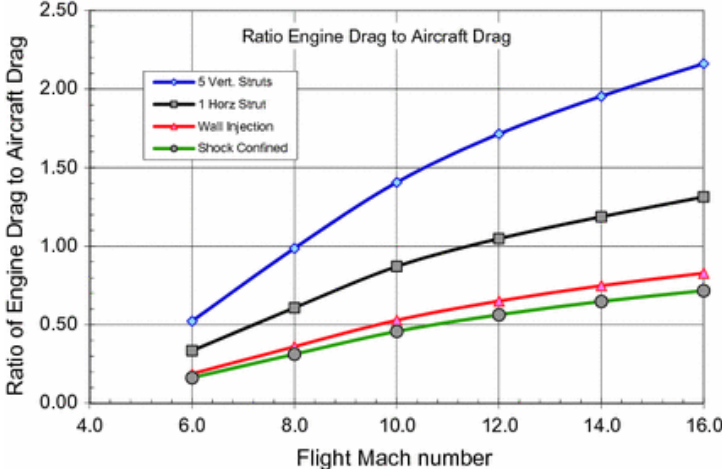
Figure 3. Ratio of engine drag to aircraft drag vs flight Mach.